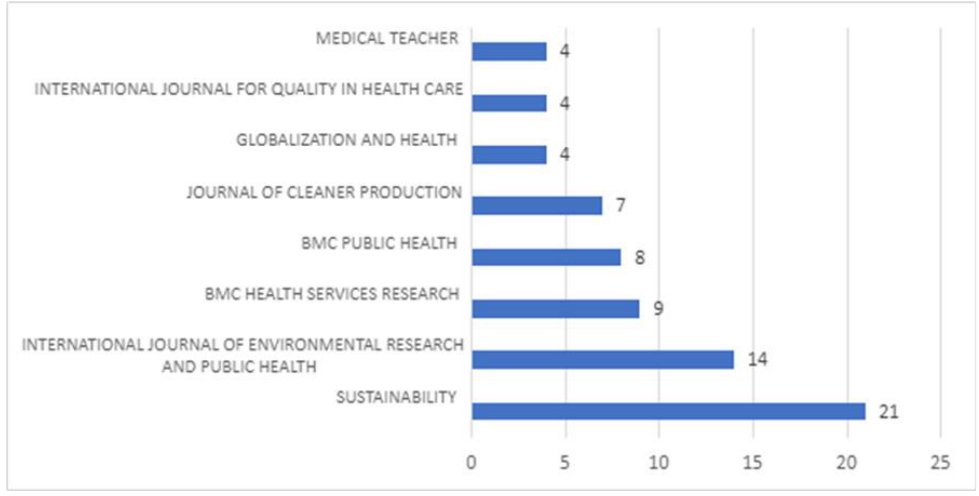
Figure 8. Number of papers per journal .